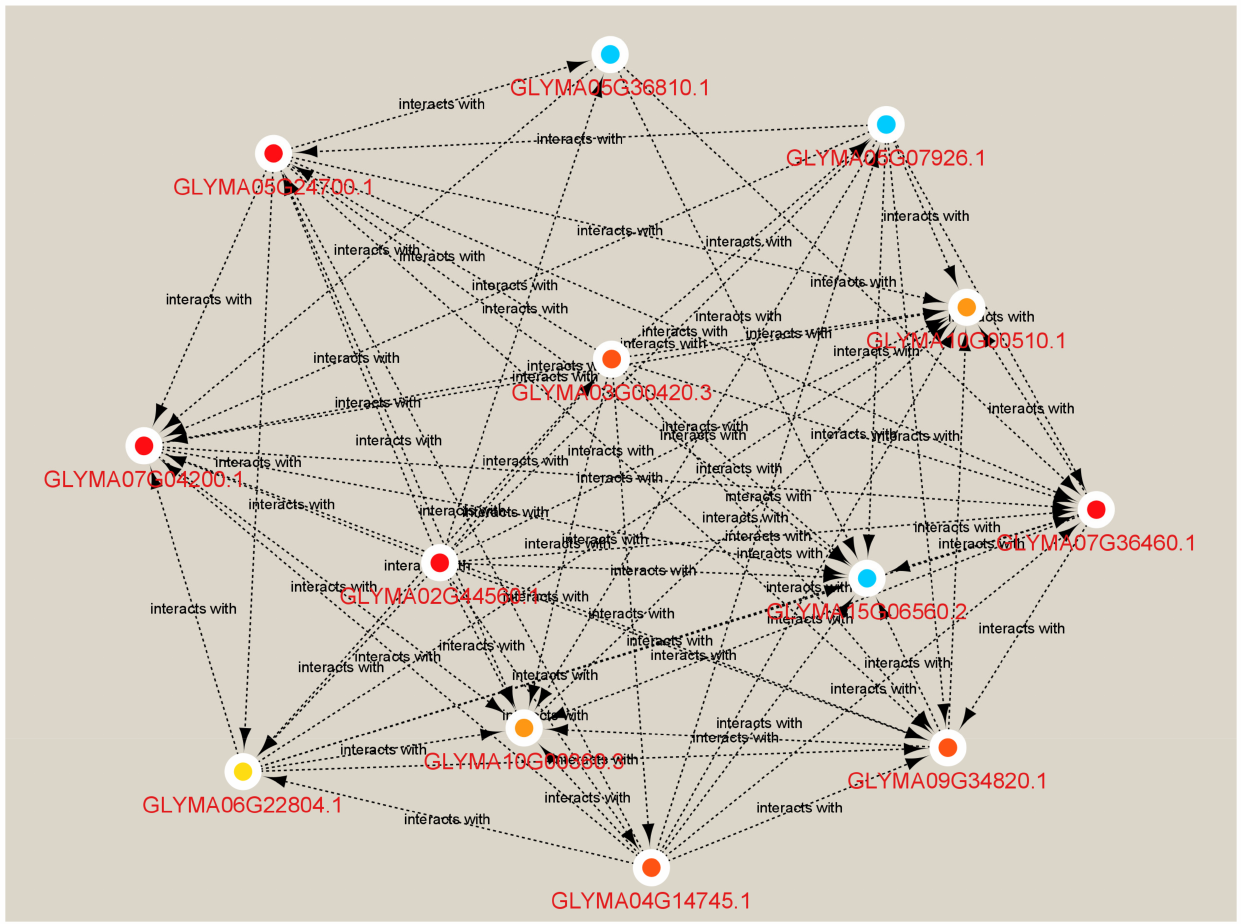
Figure 6. PPI network of candidate genes in soybean on the basis of STRING